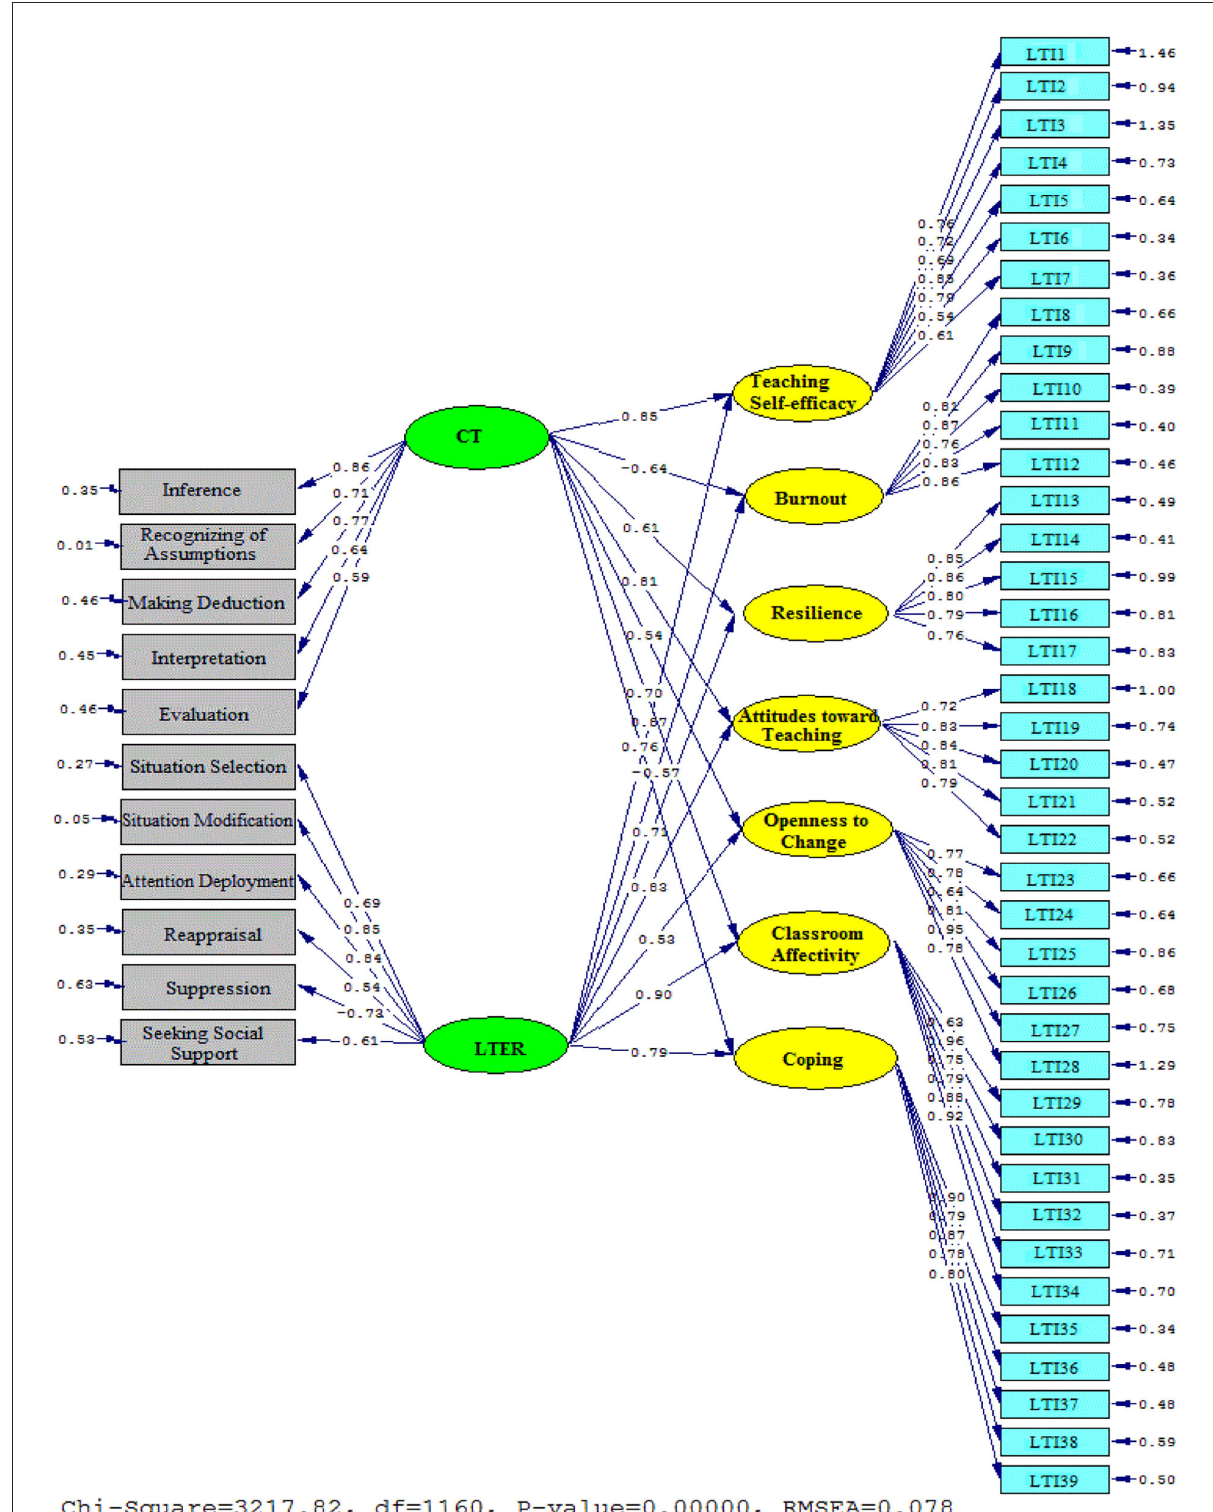
FIGURE4 Schematic representation of path coefficient values for the influential role of critical thinking and self-efficacy on teaching style’ subscales (model